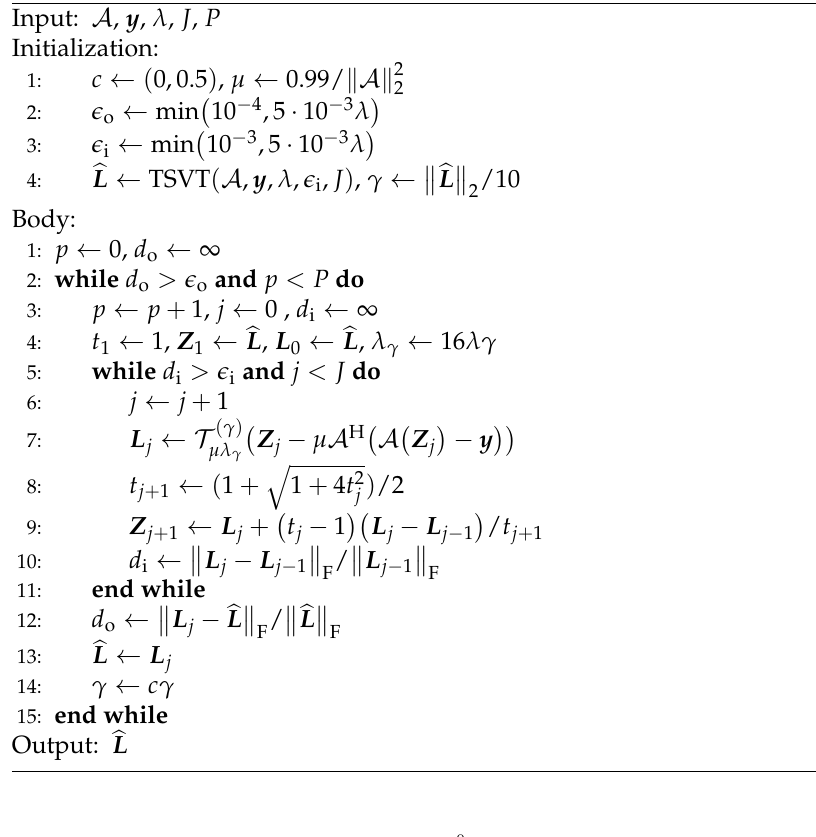
Algorithm 4 The CSRA algorithm.